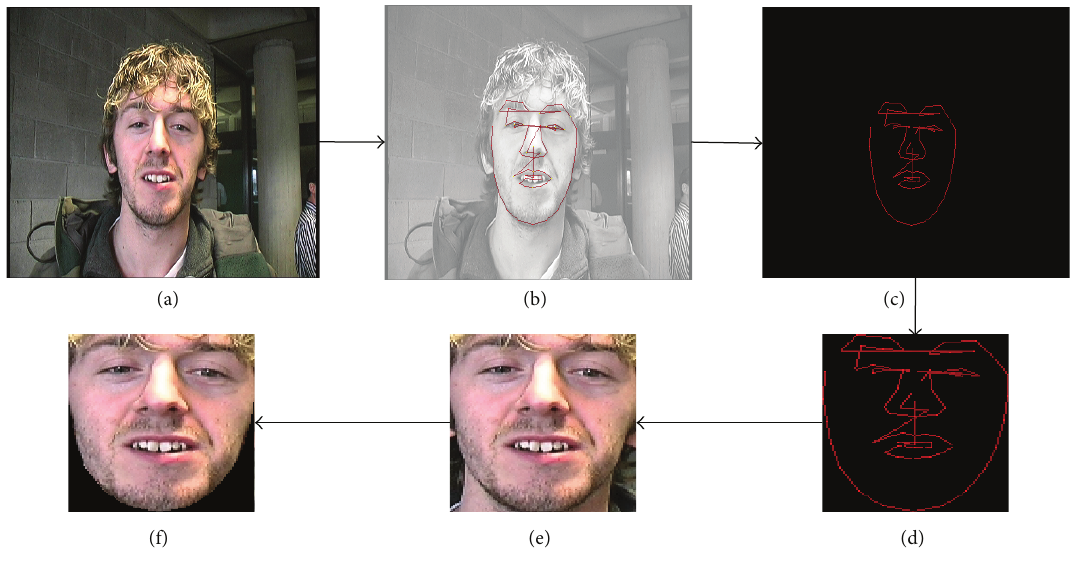
Figure 2: Facial image before processing for the proposed systems: (a) original image, (b) output taken from Stams Active Appearance Model, (c) extracted facial edges, (d) shape based features, (e) region of interest (ROI) selection with background noise, and (f) appearance based facial